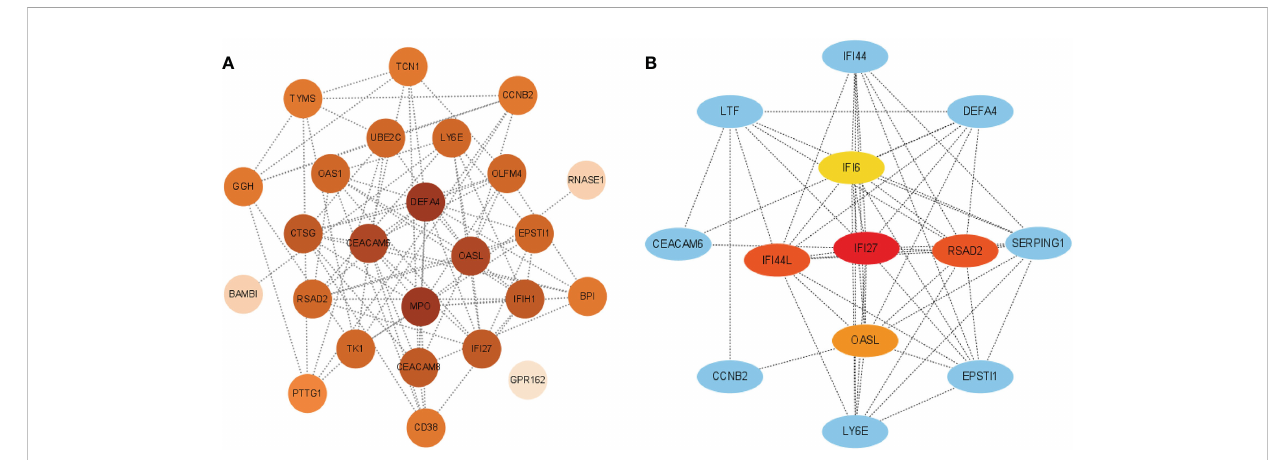
FIGURE 8 (A) PPI network of common DEGs among SARS-CoV-2, H1N1, and In fl uenza. The PPI network was generated using String and visualized in Cytoscape. (B) Determination of hub genes from the PPI network by using the Cytohubba plugin in Cytosacpe.